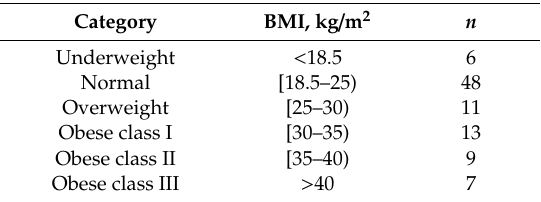
Table 1. Distribution of Body Mass Index in